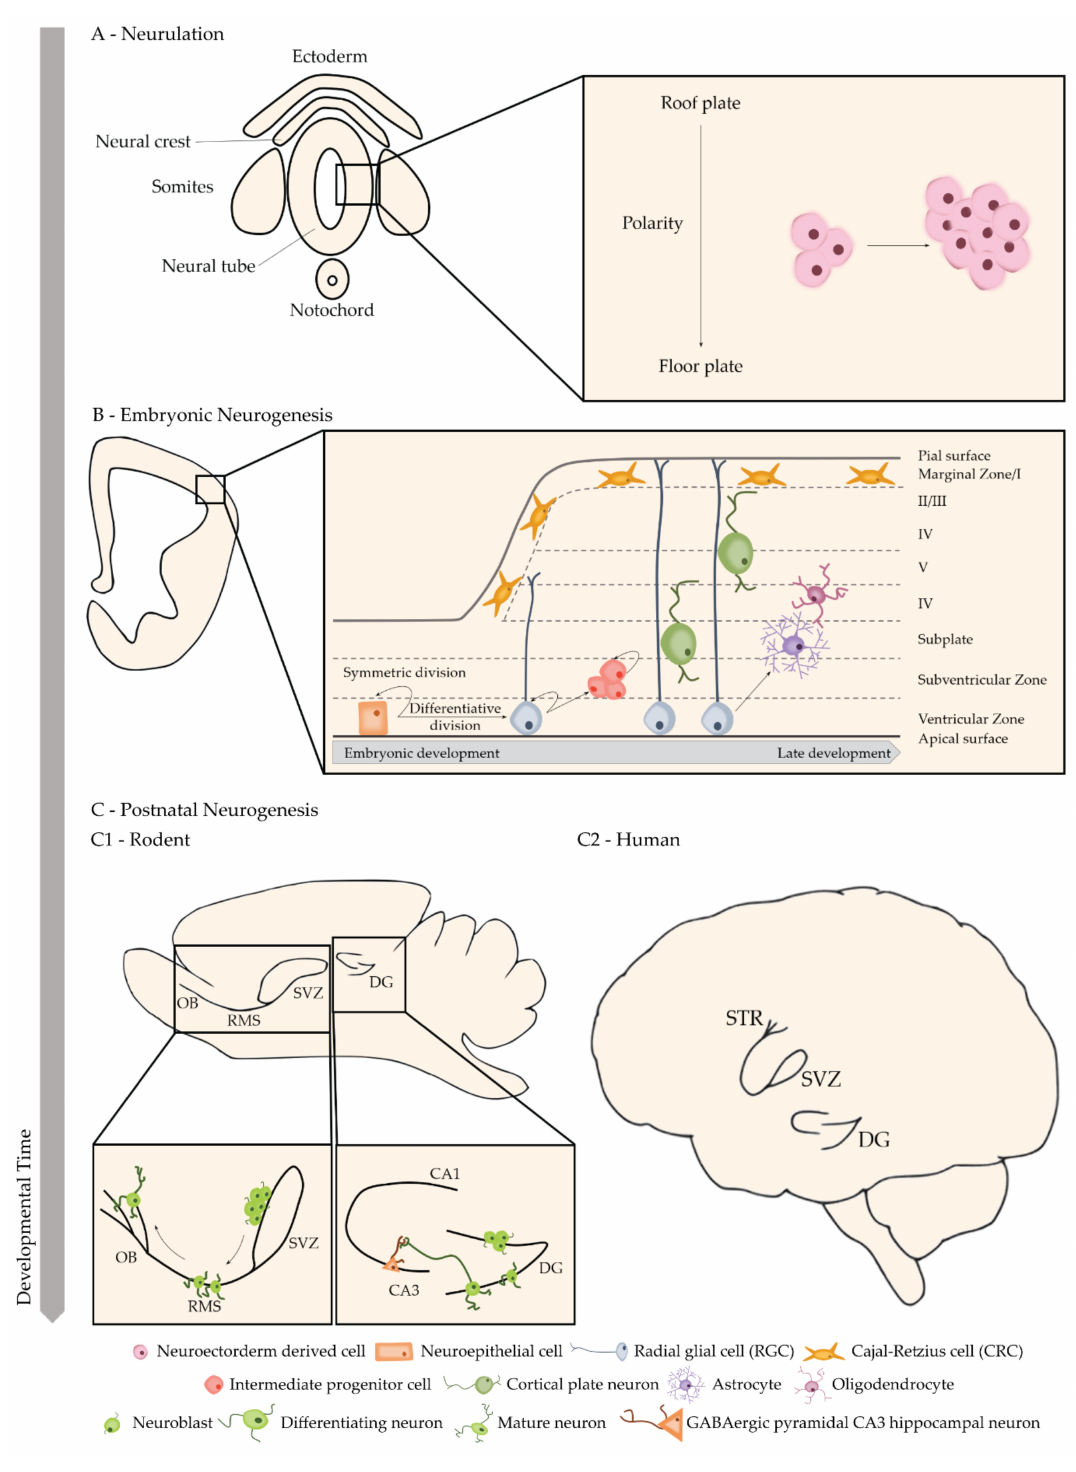
Figure 2. Neurogenesis. ( A ) Neurulation. Schematic representation of the neurulation process. Neuroectoderm derived cells proliferate at different rates along the apicobasal polarity. ( B ) Embryonic Neurogenesis. During embryonic development the central nervous system develops in an inside-out fashion. Neuroepithelial stem cells, via asymmetrical divisions, differentiate into radial glial cells (RGCs), establishing the Ventricular Zone near the apical surface. Near the pial surface, Cajal- Retzius (CRCs) cells will make the marginal zone during embryogenesis and the cortical layer I postnatally. The other cortical layers are formed in sequential waves during neurogenesis. Later in